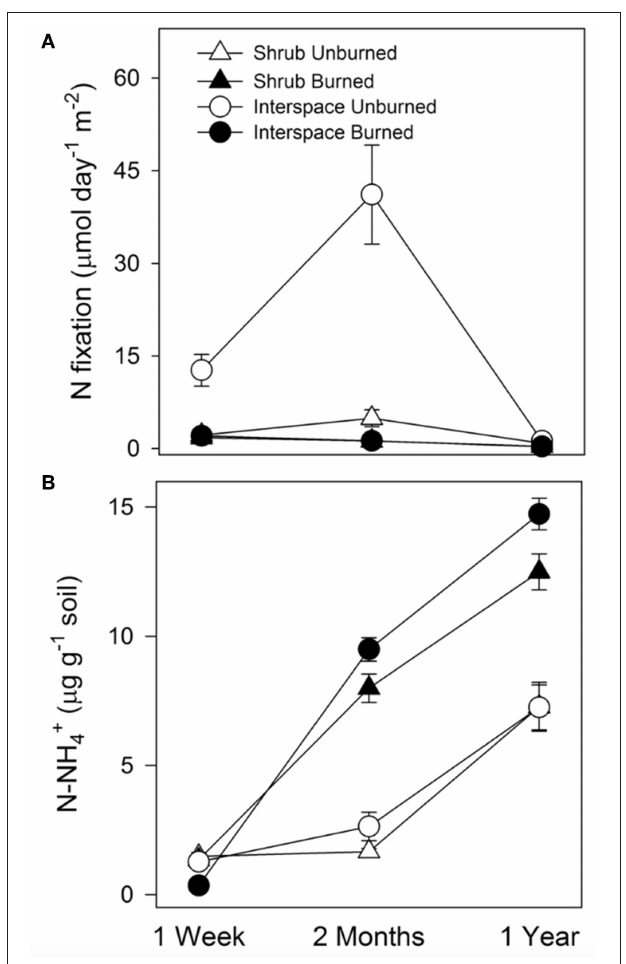
FIGURE 6 | N fixation rates (A) , and ammonium concentrations (N-NH + 4 ) (B) in unburned and burned biocrusts following fire. N fixation ( µ mol day − 1 m − 2 ) and inorganic N ( µ g N-NH + 4 g − 1 soil) values are means ( n = 10) ± SEM. Differences between treatments are based on RM-ANOVA results from three time intervals following fire (1-week, 1-month, and 1-year).